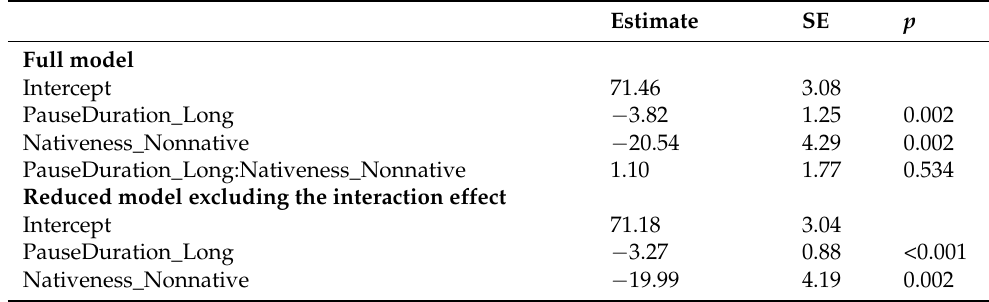
Table 2. Results of the linear mixed model exploring the effects of pause duration and nativeness on perceived confidence. The table reports estimated model coefficients (Estimate), standard errors (SE) and p -values ( p ). Because of the non-significant interaction effect in the full model, to determine the effects of pause duration and nativeness alone, we also report the results of a reduced model excluding this interaction effect.